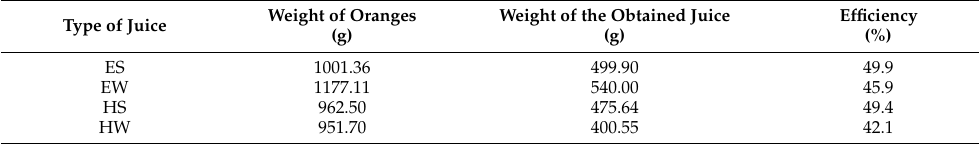
Table 5. Weight of oranges, the weight of juice, and percent efficiency. Type of Juice Weight of Oranges